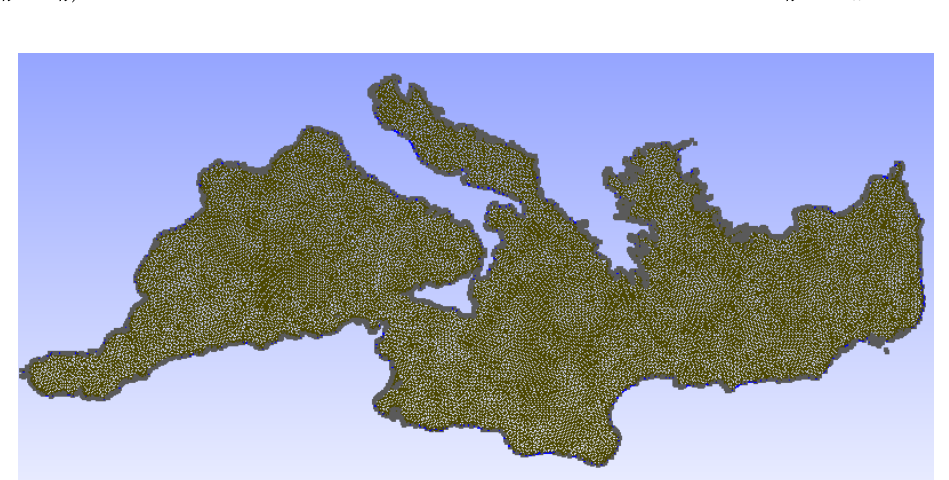
Figure 2. Triangulation of the Mediterranean Sea suitable for simulations with finite element methods which was used in [30,60] (see also